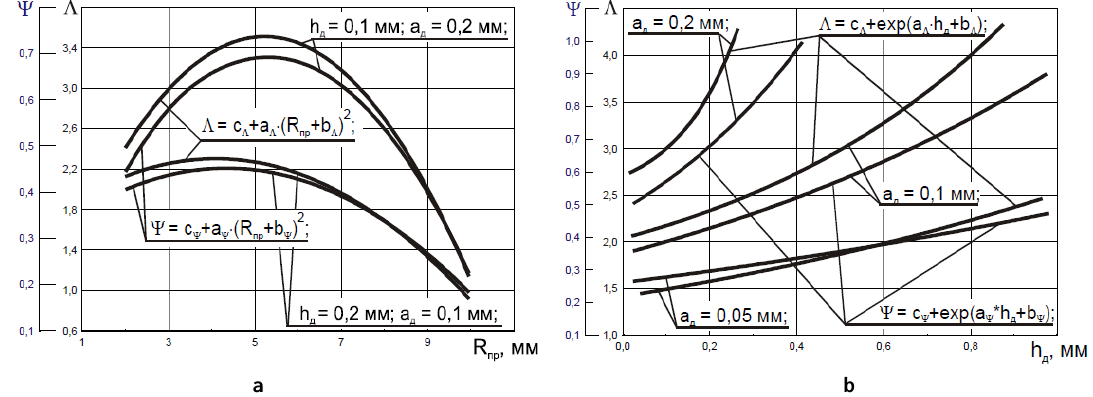
Fig. 1. Interrelationships of the accumulated parameters of the mechanical state: a - with profile radius of the roller; b - with real tension